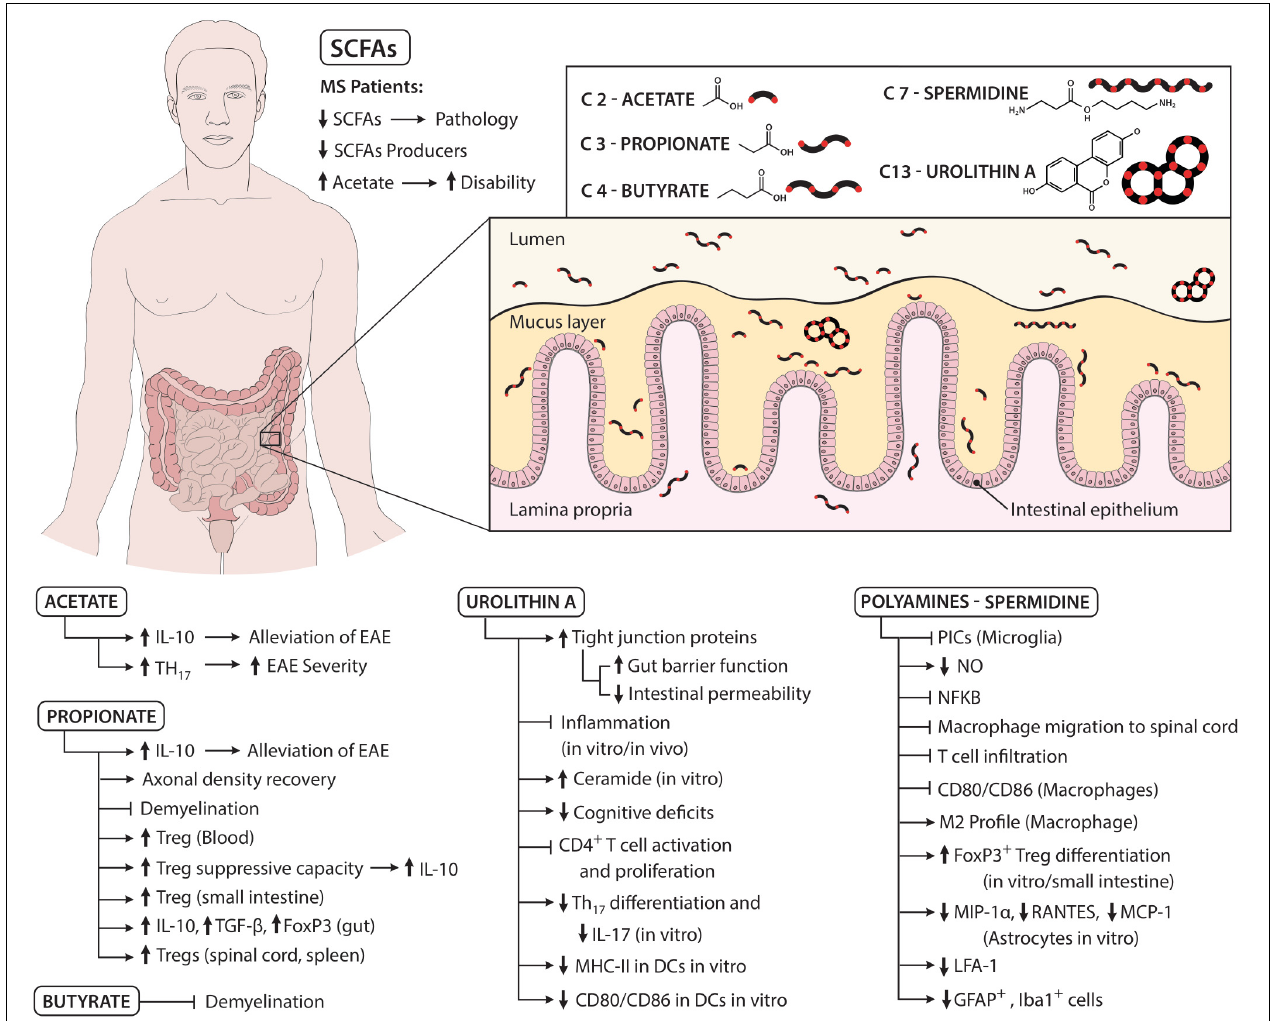
FIGURE 1 | Schematic summarizing the role of microbial metabolites in the pathogenesis of MS. MS patients have reduced levels of SCFAs and SCFAs producers, which is associated with a more severe pathology. However, levels of acetate are increased in MS patients, which is linked with more disability. Acetate can both have detrimental and beneficial effects. For instance, acetate leads to more IL-10 secretion and thus alleviates EAE. On the other hand, acetate is also able to increase the frequency of Th17 cells and thus aggravate EAE. Propionate increases axonal density recovery and inhibits demyelination, the latter also being mediated by butyrate. Furthermore, propionate augments the frequency of Tregs (for instance, in the blood, spinal cord, and spleen) and their suppressive capacity while also upregulating IL-10, TGF- β , and FOXP3 levels in the gut. Polyamines, specifically spermidine, inhibit pro-inflammatory cytokines, and nitric oxide (NO) secreted by microglia likely via suppression of the NF- κ B pathway. Moreover, spermidine inhibits macrophage and T cell migration to spinal cord and downregulates the levels of CD80 and CD86 on macrophages. Furthermore, spermidine shifts macrophages to the alternative or M2 profile, increases FOXP3 + Tregs differentiation, decreases chemokine secretion by astrocytes and the levels of LFA-1 on T cells and decreases the number of GFAP + and Iba-1 + cells. Urolithins, specifically urolithin A (UA), increase tight junction protein levels and gut barrier function, which decreases intestinal permeability. Furthermore, UA inhibits inflammation, reduces cognitive deficits, diminishes Th17 differentiation, IL-17 secretion, MHC-II, CD80, and CD86 expression on DCs. Moreover, UA increases ceramide levels and blocks CD4 + T cell activation and proliferation. Altogether, these molecules, alone or synergistically, act to promote host homeostasis, but disease states and changes in diet